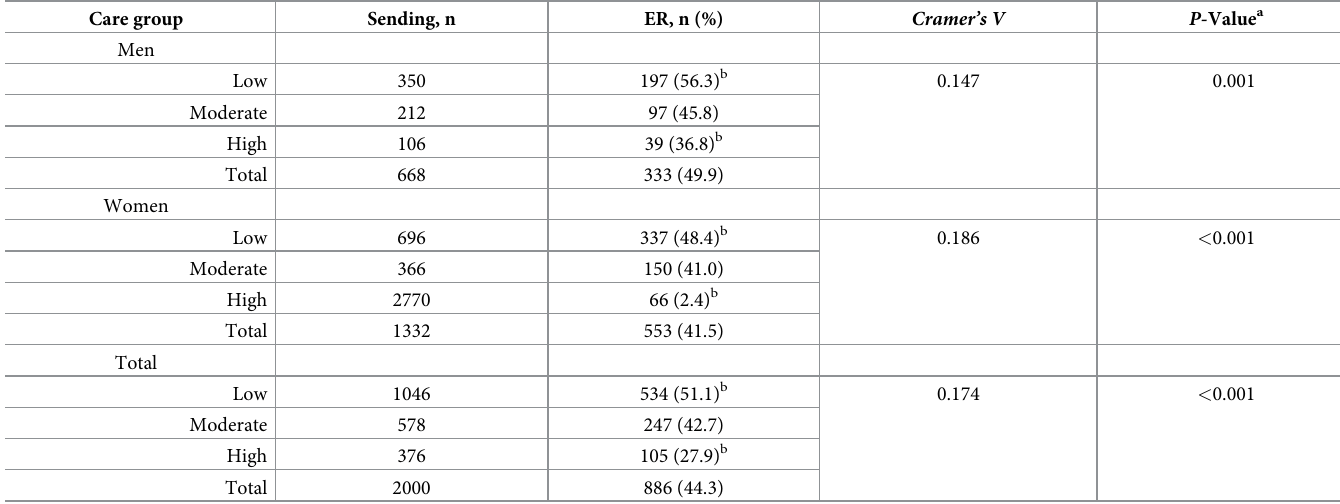
Table 3. Effective response rate in long-term care insurance beneficiaries.